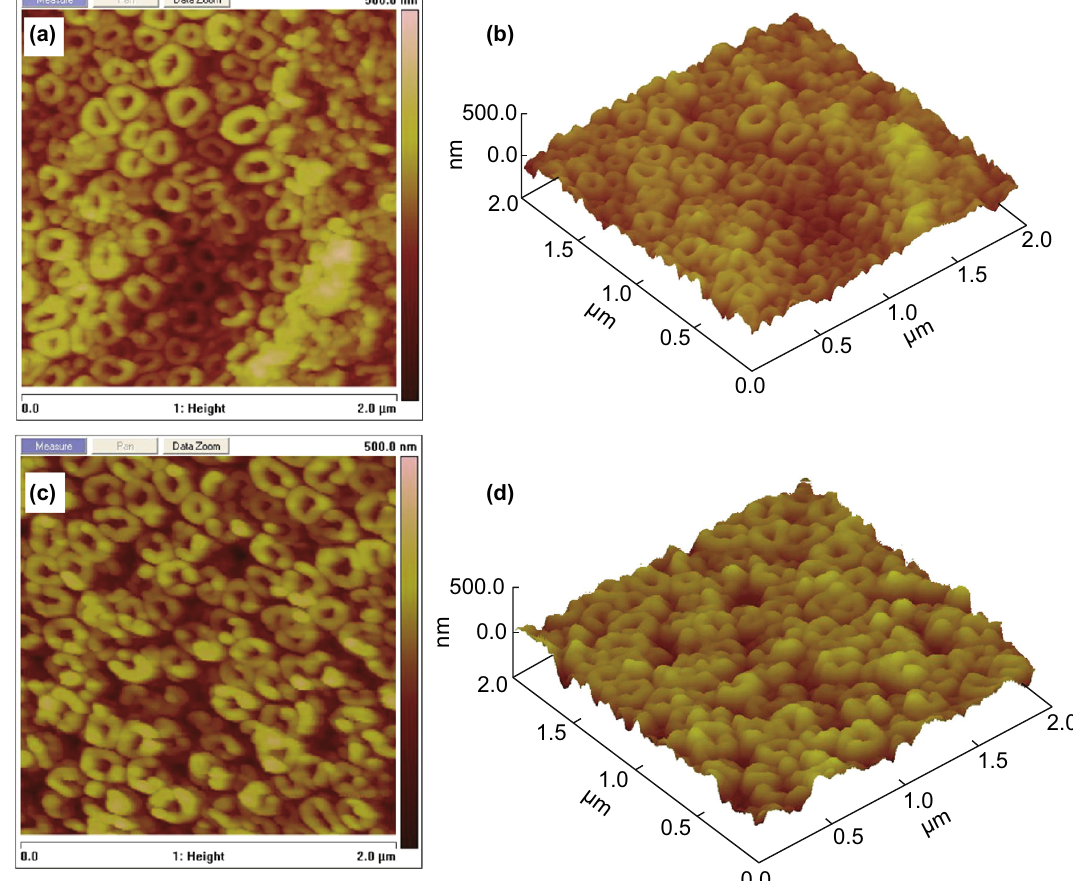
Fig. 5 Top view and 3D AFM images (2 9 2 l m 2 ) of a , b TNTAs and c , d g-C 3 N 4